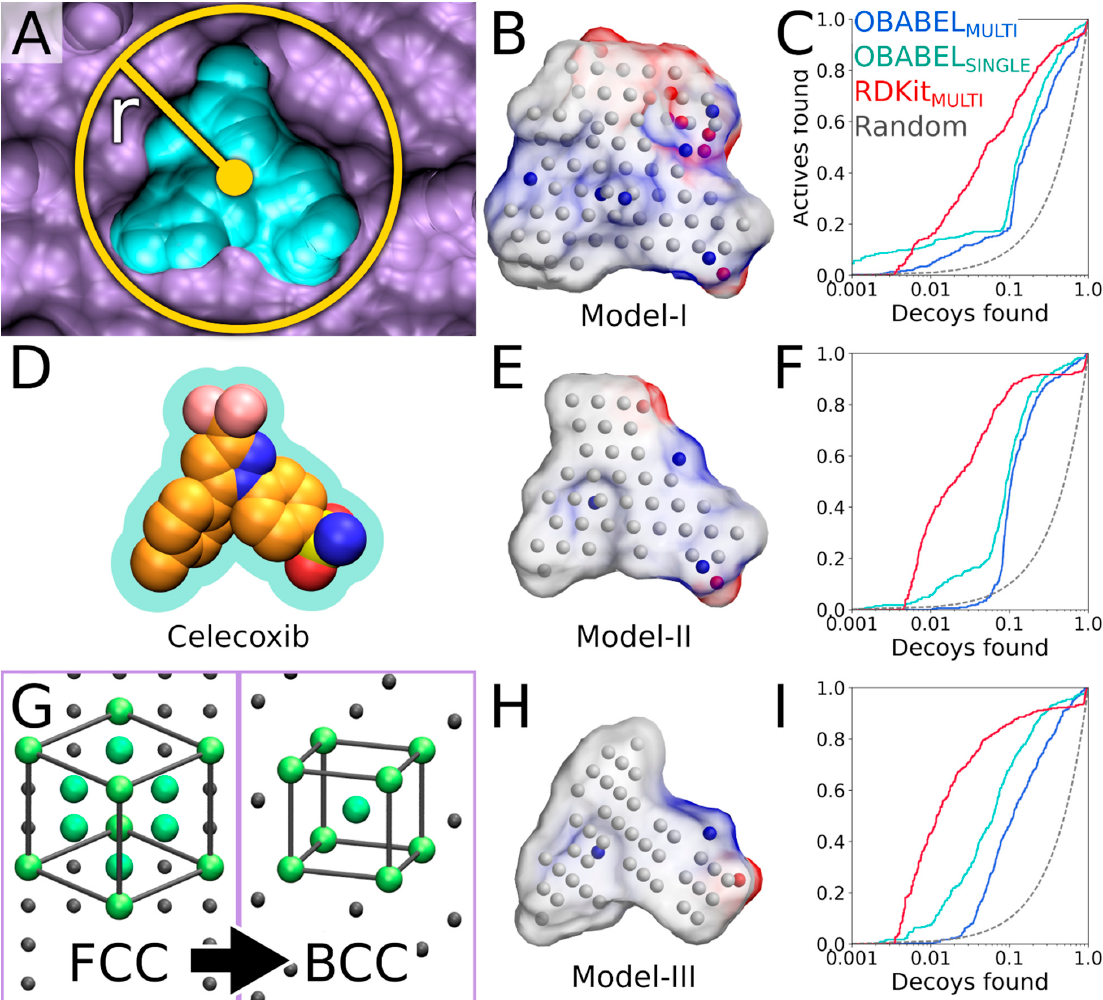
Figure 4. The negative image-based screening benchmarking evolution. ( A ) A cross section of the ligand-binding cavity (cyan) of the cyclooxygenase-2 (magenta; PDB: 3LN1; A chain) shown with the cavity centroid and detection radius (r = 10 Å). ( B ) The NIB (negative image-based) Model I, generated using the default PANTHER settings, ( C ) produced higher enrichment for the DUD test set using RDKit multi-conformer set (red line) than the multi-conformer OBABEL set (blue line; Table 3). The single-conformer OBABEL set (cyan line) resulted in higher early enrichment (Table 2) than its multi-conformer set. ( D ) The bound inhibitor (CPK model) is shown with the extra 1.5 Å volume. ( E ) Model II, fashioned using the 1.5 Å ligand distance limit, has roughly similar shape as the inhibitor ( D versus E ). ( F ) The enrichment was improved with Model II for the RDKit set over the prior model; however, the early enrichment weakened with both OBABEL sets (Tables 2 and 3). ( G ) Models I and II were generated using the face-centered cubic (FCC) packing. The body-centered cubic (BCC) lattice packing was used for Model III. ( H ) Model III has less dense packing than Model II ( E versus H ). ( I ) Model III worked best with the RDKit conformers, but the effect was lesser for the OBABEL sets (Tables 2 and 3). See Figure 1 for interpretation.